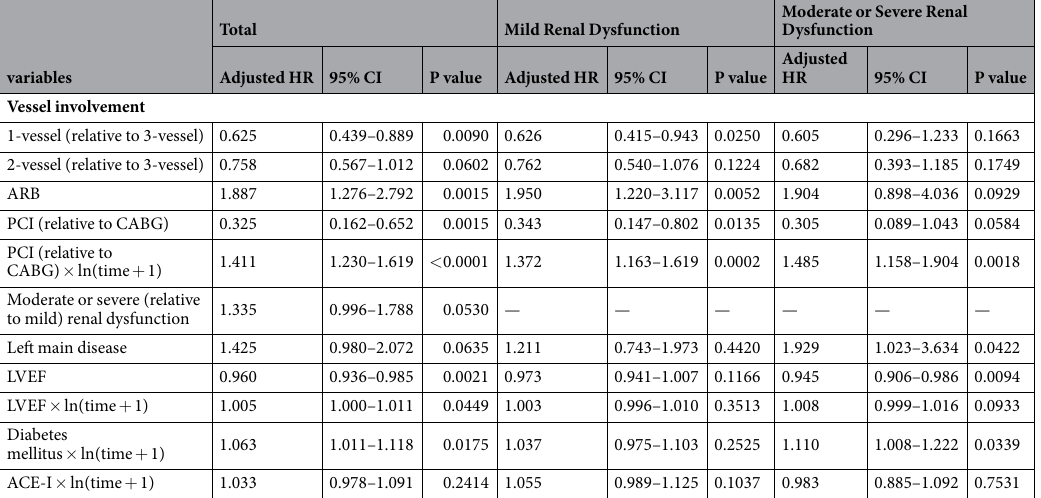
Table 3. The adjusted time-dependent Cox models for predictors of MACCE. predictor × ln(time + 1) indicates the interaction between the predictor and time effect (natural logarithmic transformation of ‘time +